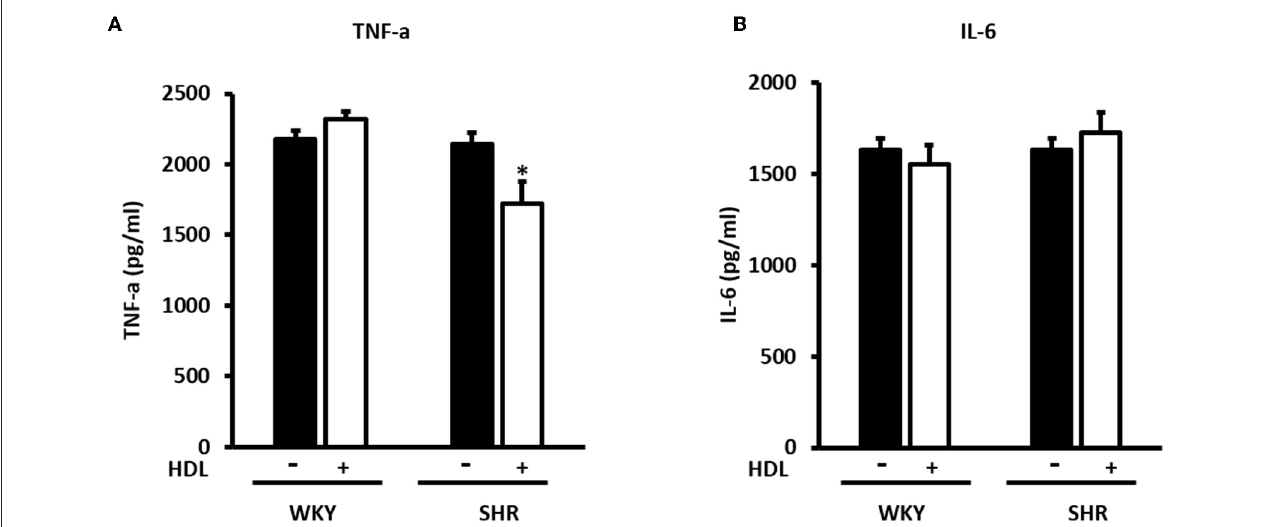
FIGURE 10 | Effect of chronic HDL treatment on inflammatory markers in WKY and SHR. The levels of TNF- α (A) and IL-6 (B) from hearts treated (chronically) with or without HDL and subjected to I/R injury. Data are means ± SEM, * P < 0.05, n = 5–8 rats per group.